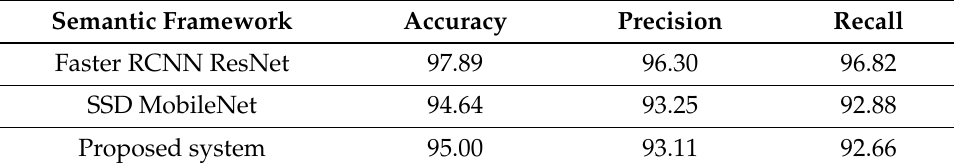
Table 5. performance comparison of object detection frameworks.